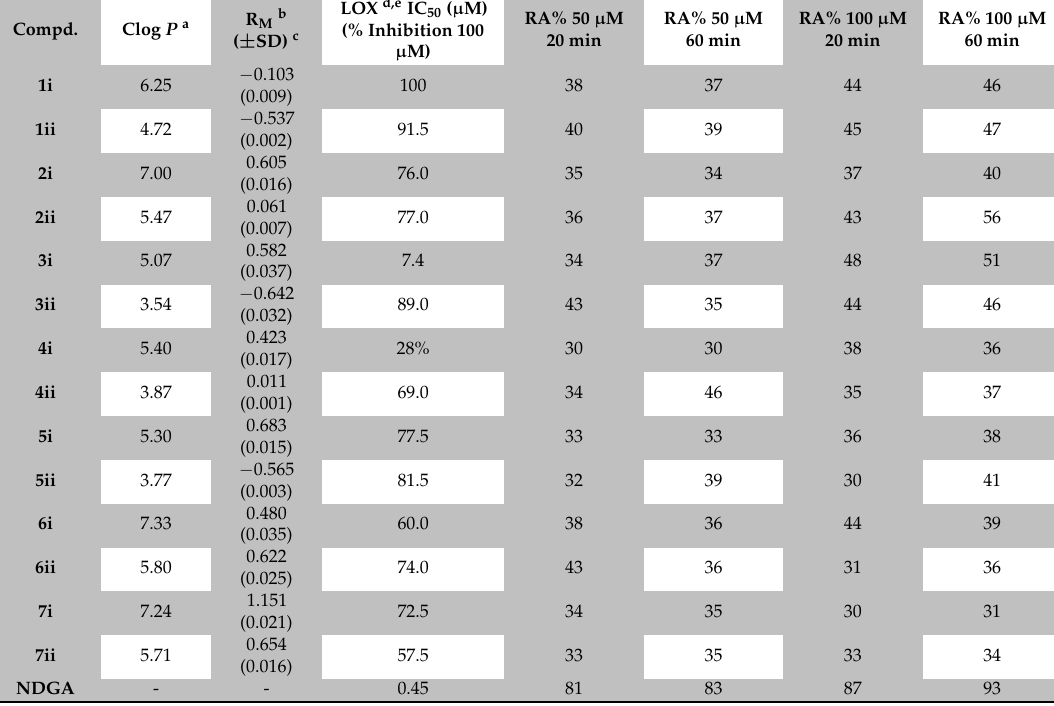
Table 1. In vitro lipoxygenase (LOX) inhibitory activity at 0.01 µ M or IC 50 ( µ M). % Interaction with the stable radical 1,1-diphenyl-picrylhydrazyl (DPPH). Lipophilicity values: experimental R M and determination of lipophilicity as clog P